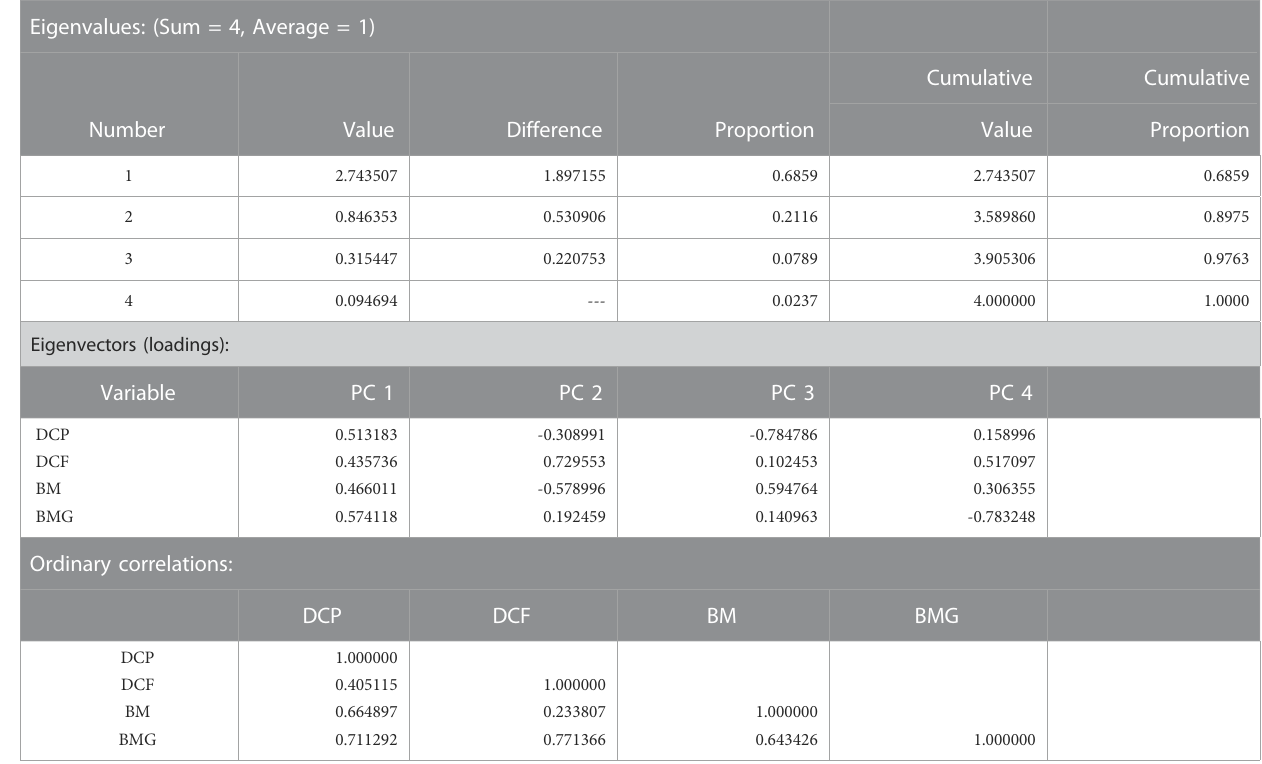
TABLE 5 Results of PCA for FD index